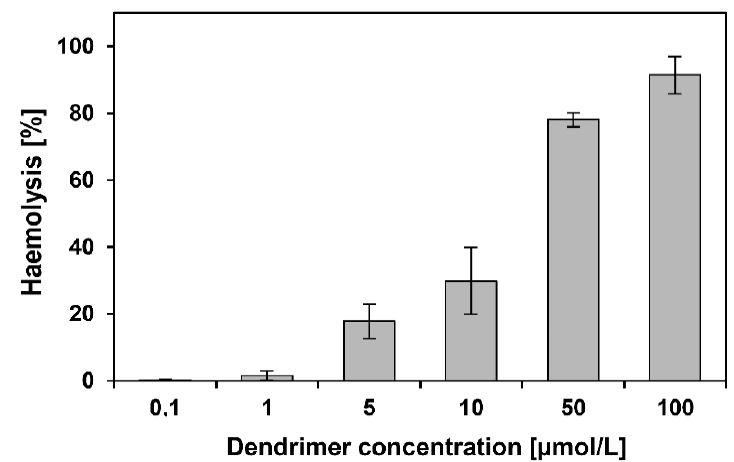
Figure 5. Haemolysis induced after 24h treatment of red blood cells with ruthenium terminated carbosilane dendrimer with FITC (CRD13-FITC) at 0.1–100 µmol/L. Two percent haematocrit in PBS buffer at pH 7.4 and 22 °C. Results are mean ± SD, n = 6.